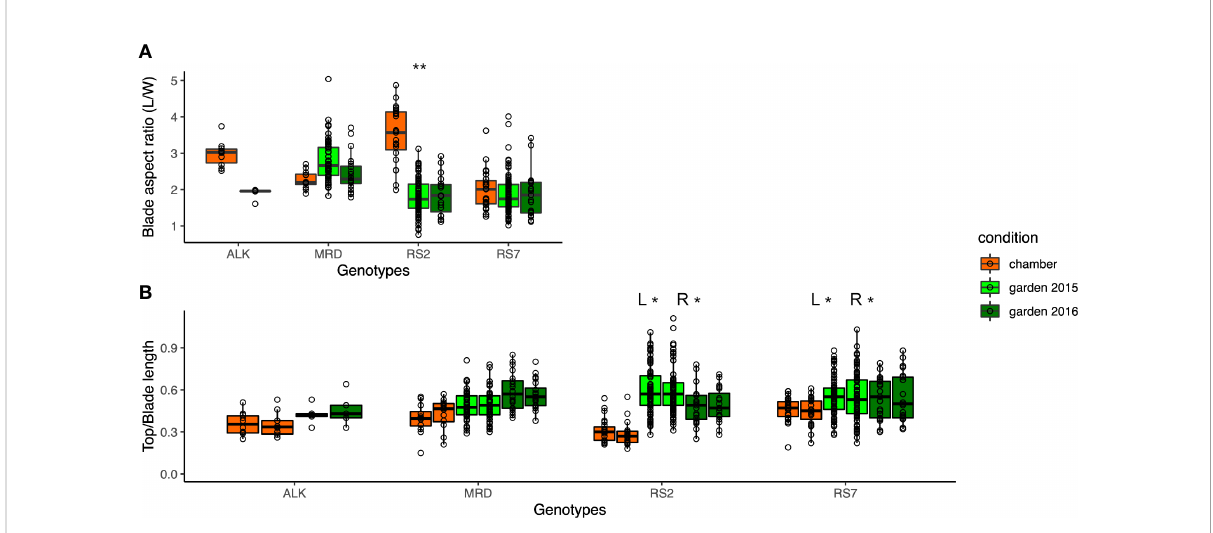
FIGURE 3 The traits representing the balance of the blade shape. (A) Blade aspect ratio is calculated by dividing the blade length by the sum of the left- and right-blade width. (B) Ratio of top length is calculated by dividing the top length by the blade length, representing the relative size of the upper round part of the leaf. The asterisk represents the P-value by Levene test (*: P<0.05; **: P<0.01; ***: